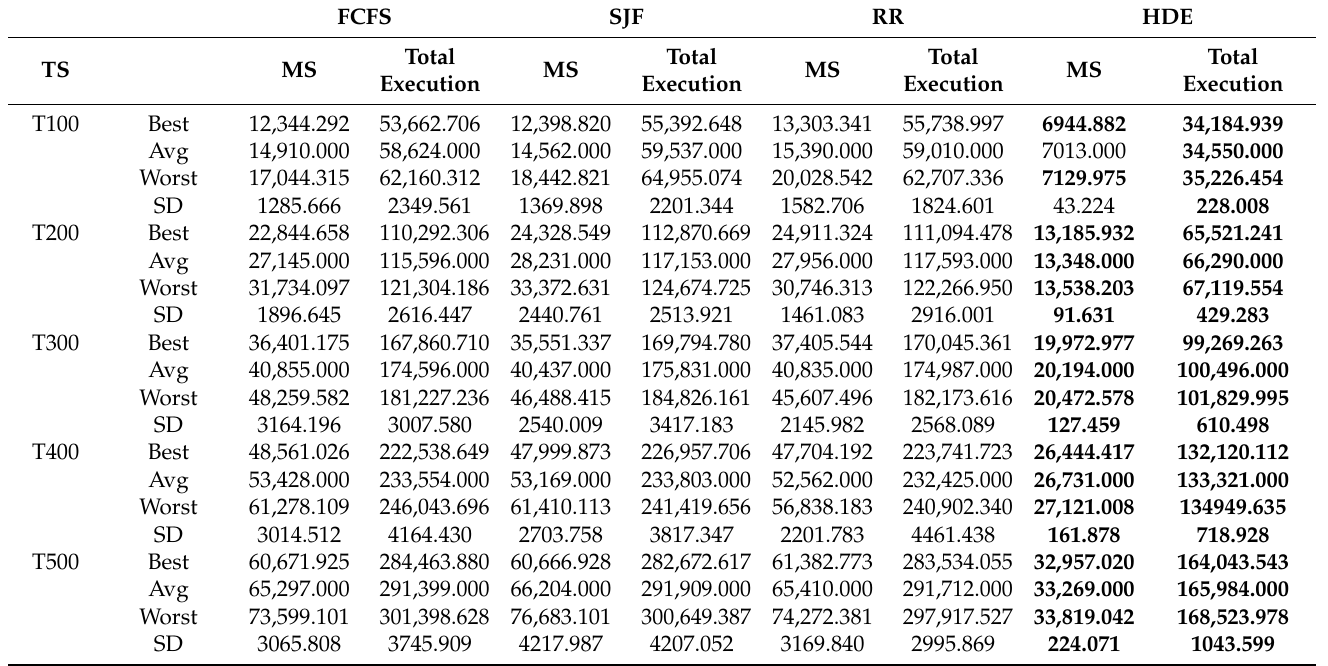
Table A5. Comparison with heuristic algorithms for the total execution time and